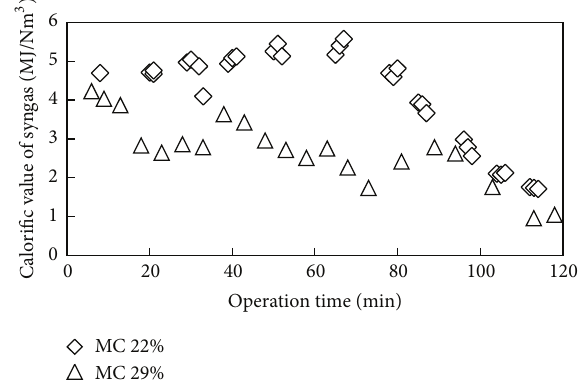
Figure 7: Variation of calorific value with operation time for fuel of different initial moisture